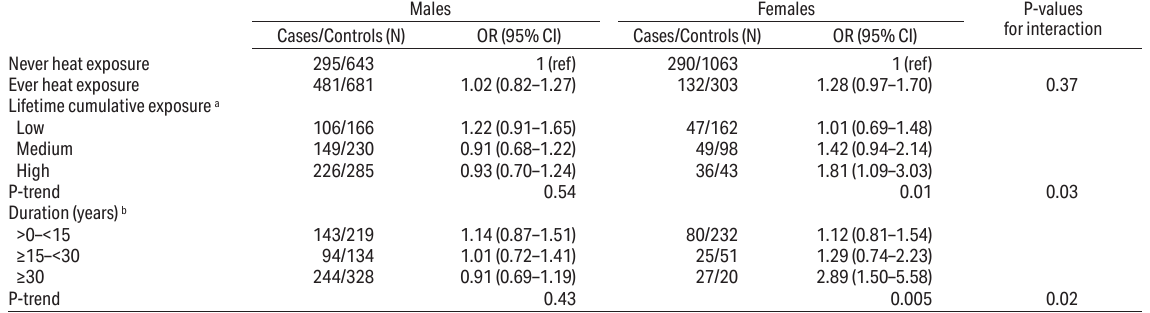
Table 3. Associations between occupational heat exposure and colorectal cancer stratified by sex [OR=odds ratio; CI=confidence interval]. All models are adjusted for age, region, education, cigarette smoking, family history of colorectal cancer, body mass index, and occupational physical activity.